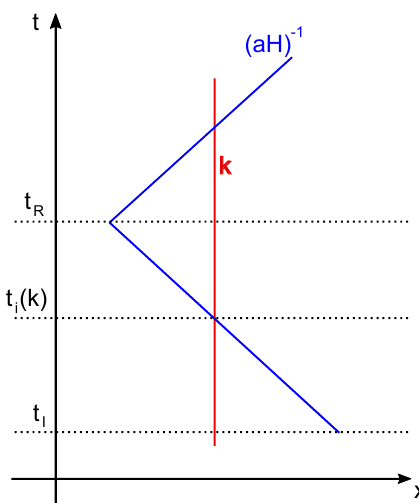
Figure 2 . Space-time sketch (with the horizontal axis depicting comoving spatial coordinate and the vertical axis being time) showing the evolution of the comoving Hubble radius ( aH ) (cid:0) 1 during and after Stage 3 (beginning at time t I and ending at time t R ) of our model. The wavelength of a (cid:13)uctuation mode (the vertical line labelled by k ) exits the Hubble radius at a time t i ( k ) and then re-enters at some late